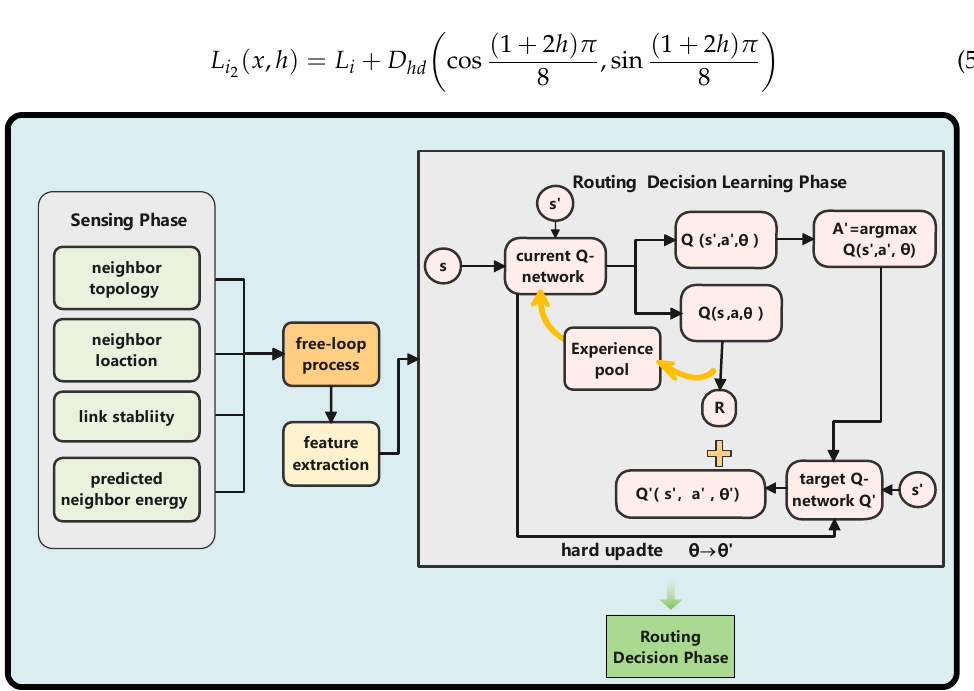
Figure 2. DSEGR protocol